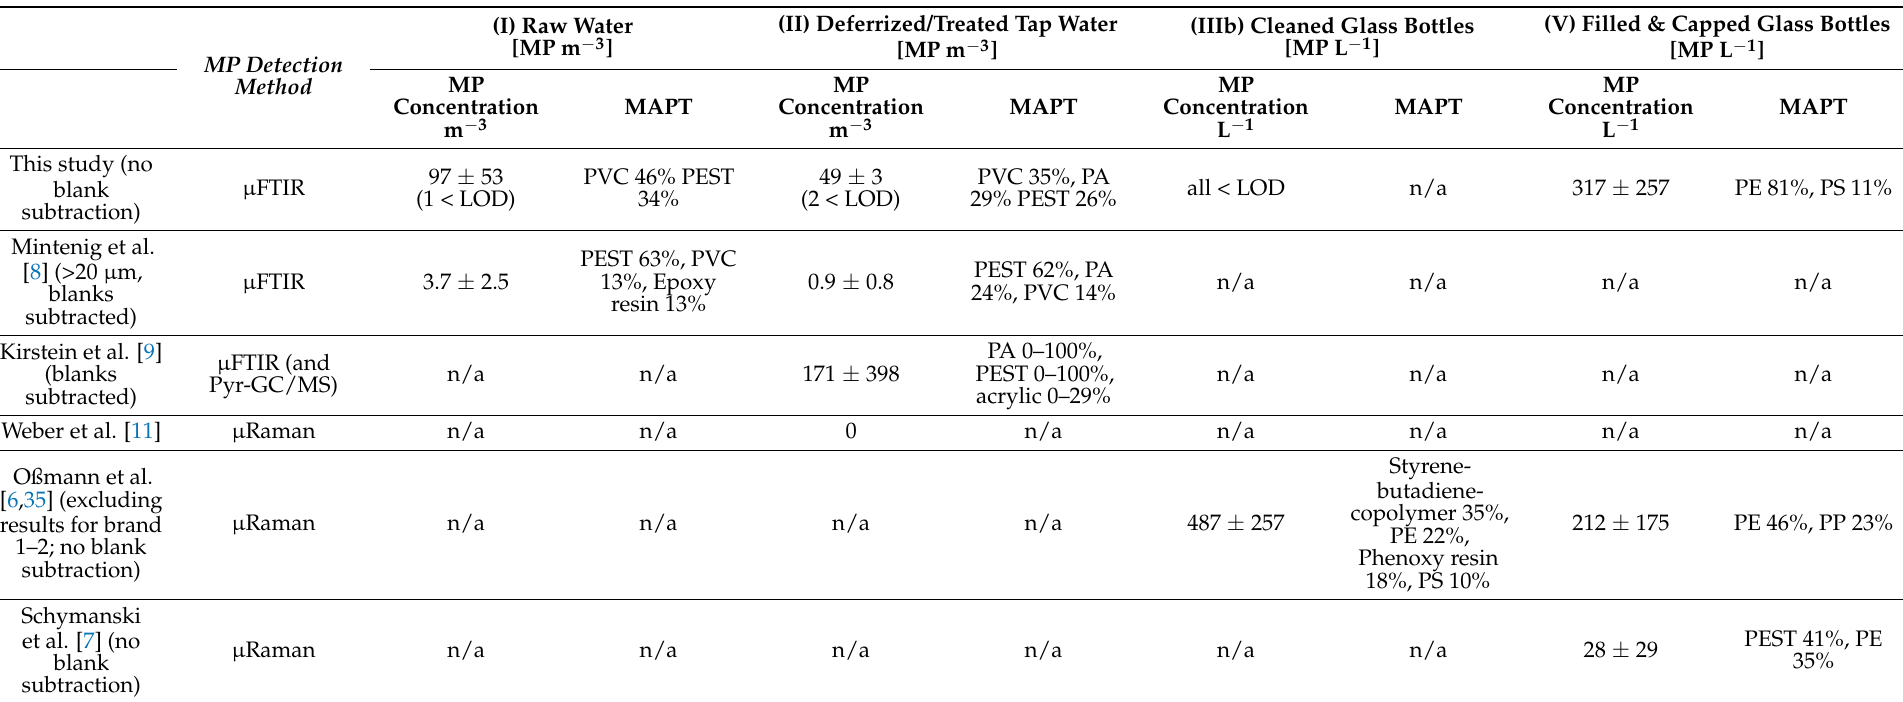
Table 3. Summary of results from this and other studies, confined to MP > 10 µ m (calculated from published MP concentrations and size distributions, except for Mintenig et al. [8] whose lower detection limit was 20 µ m, see Table S9) and spectroscopic detection methods. MP particle concentrations given in mean ± standard deviation. Results < LOD were excluded. MAPT = most abundant polymer types. n/a = not available. LOD = limit of